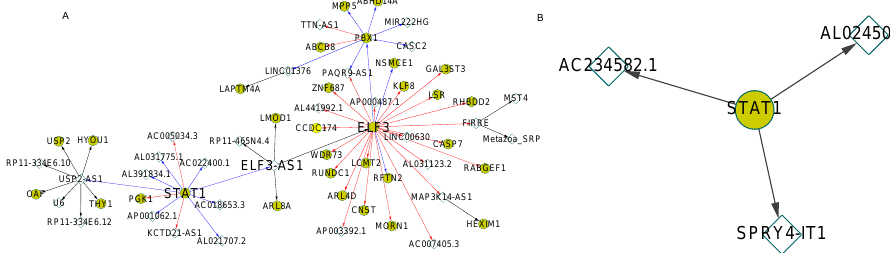
Figure 5. The regulatory cascades with transcription factor STAT1 as the root in NPCs. The expression correlation coefficients of connected genes were larger than 0.8 in the cascades. ( A ) showed the regulatory cascade in the normal samples. ( B ) represented the cascade with the root gene STAT1 in the ASD